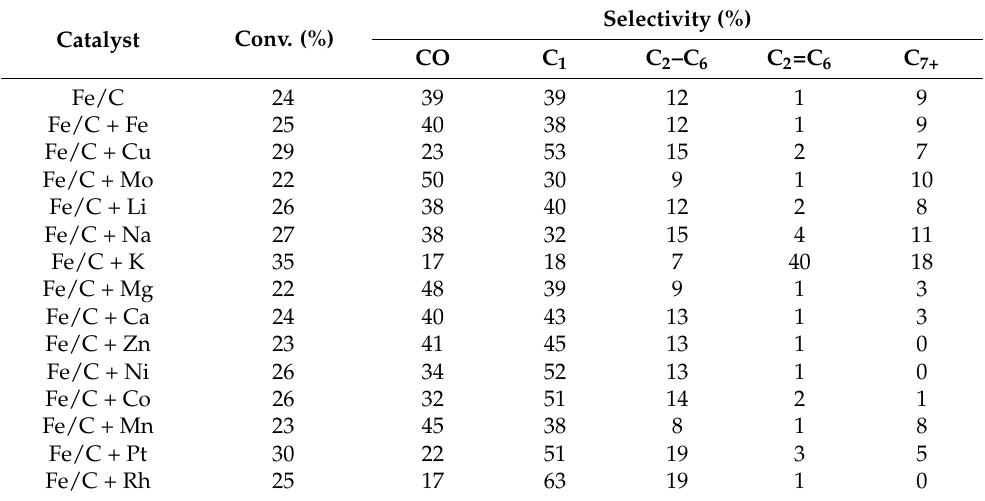
Table 2. Summary of catalytic results of Fe/C catalysts using different metals as promotors at 320 ◦ C. Selectivity (%) Catalyst Conv. (%) CO C 1